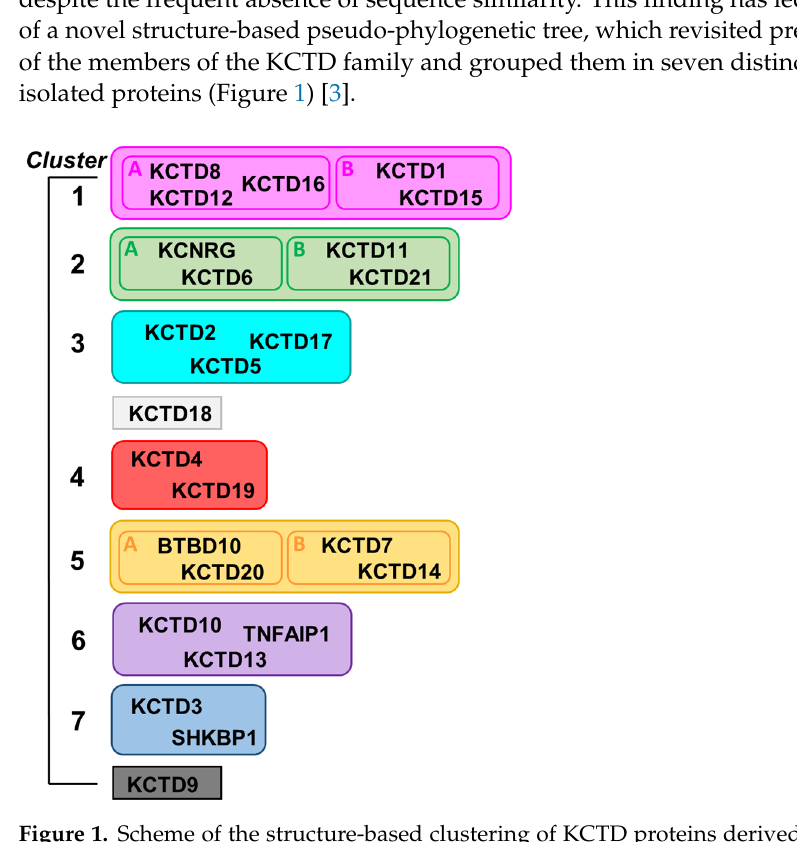
Figure 1. Scheme of the structure-based clustering of KCTD proteins derived from data reported in Reference [3].